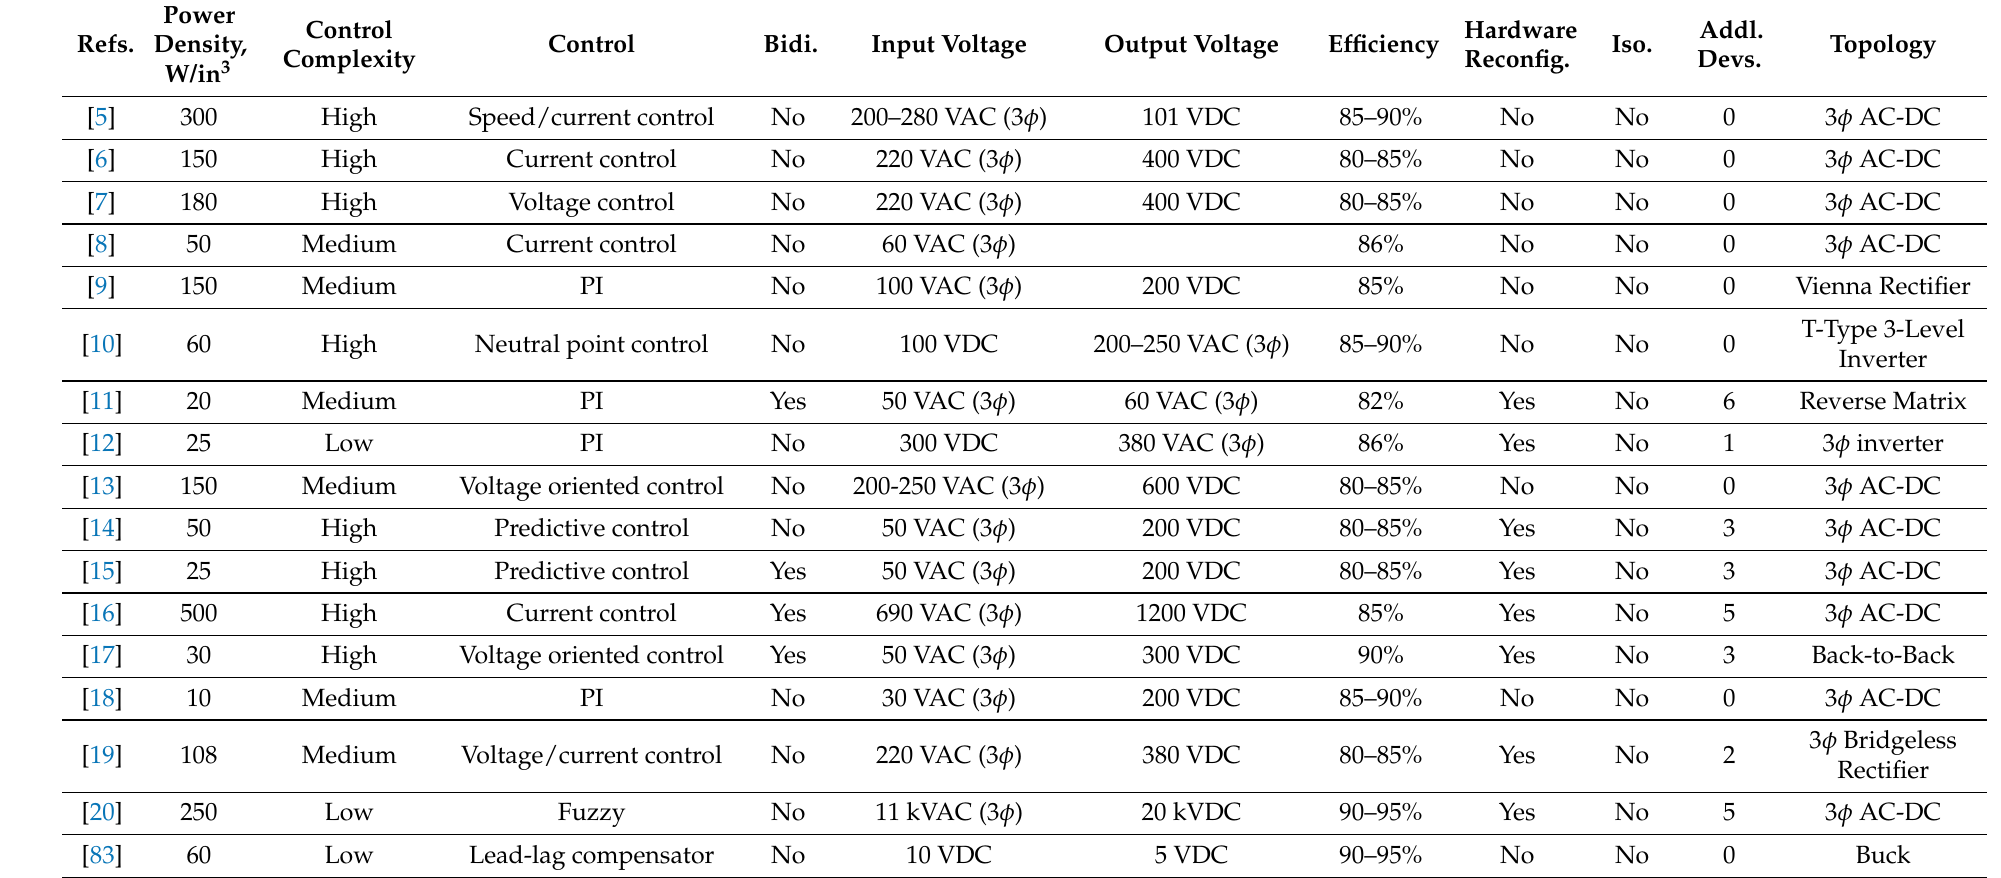
Table 1. Comparison of the different fault-tolerant switch-level